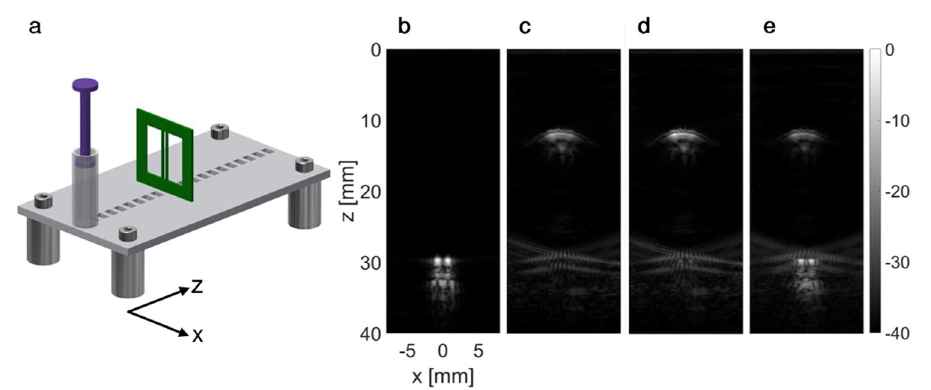
Figure 6. Wire target experimental results. Subfigures are presented with a 40 dB dynamic range. Axes are common to subfigures ( b – e ). ( a ) Illustration of the setup used in the experiment. The setup includes two wires and an obstacle, an air-filled syringe, that were placed on a base plate positioned in a water tank and imaged with a transducer. ( b ) A two-way focusing image of the two wire targets (with no obstacle along the beam path). ( c – e ) Images of the target in the presence of the obstacle using ( c ) two-way focusing, ( d ) the optimized PI method and ( e ) the BUS